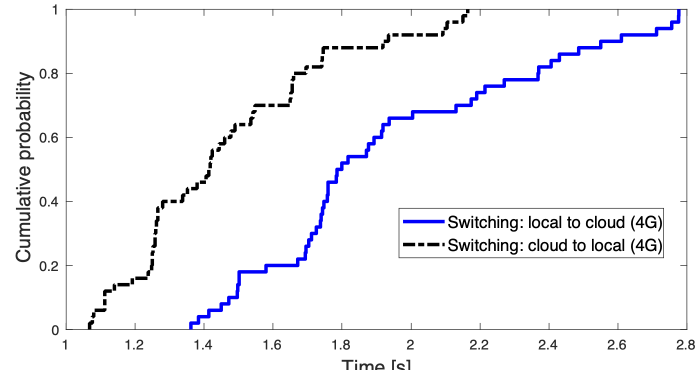
Figure 11. Switching time between edge and cloud computing on 4G network [72].